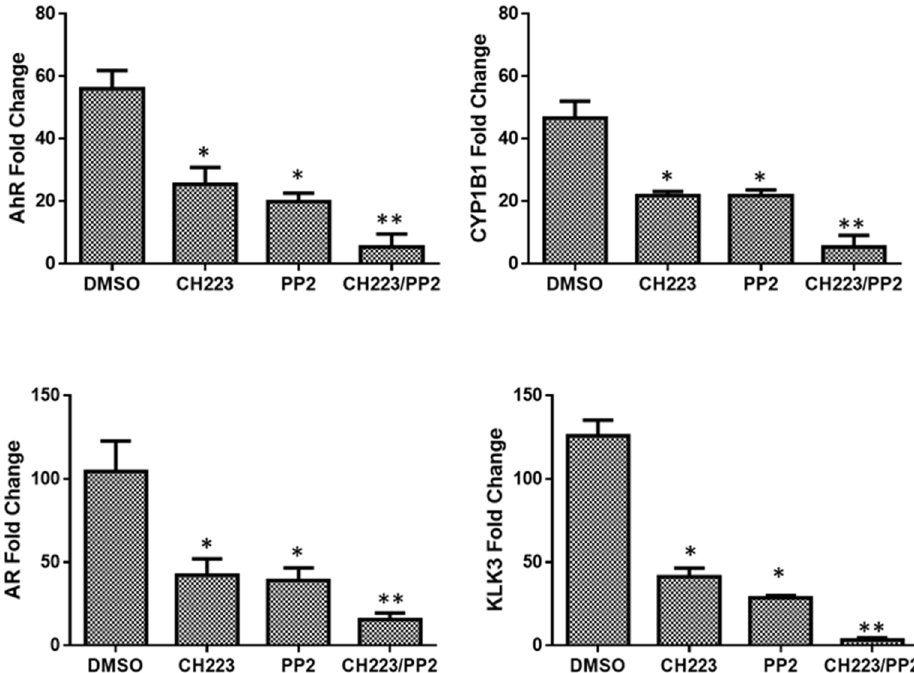
Fig 3. AhR and AR transcriptional activity synergistically ablated by CH223191and PP2. qRT-PCR analysisexaminedAhR, CYP1B1, CYP1A1, AR, KLK2 and KLK3 mRNA expressionin C4-2 prostate cancer cells. Cells were treated with 50 μ M of AhR inhibitor (CH223191) or 30 μ M of Src inhibitor(PP2) alone or in combination or with vehiclecontrol (DMSO) for 72 h and total RNAs were isolated and quantitative RT-PCR was performed to determinethe mRNA expressionof each target in treated cells. mRNA levels were normalized using L-19 which serves as an internalcontrol. Each bar represents mean ± SEM(n = 3) and were analyzedby student t-test. ( * ) denotes statistically significantdifferences ( * P < 0.05) comparedto